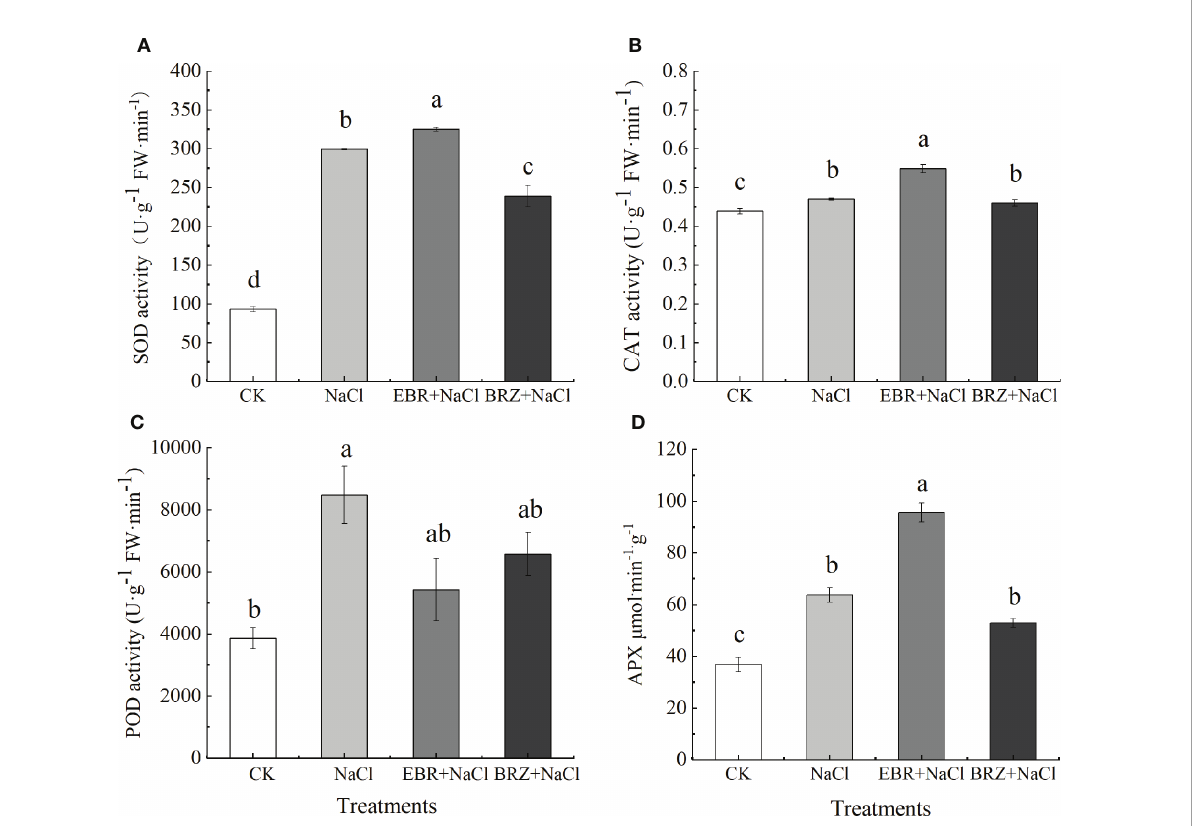
FIGURE 4 Effect of exogenous EBR on superoxide dismutase (A) , catalase (B) , peroxidase (C) and ascorbate peroxidase (D) activities in cucumber seedling leaves under salt stress. Data are means ± SE of three replicates. Different letters indicate signi fi cant differences at P < 0.05 according to Duncan ’ s multiple range